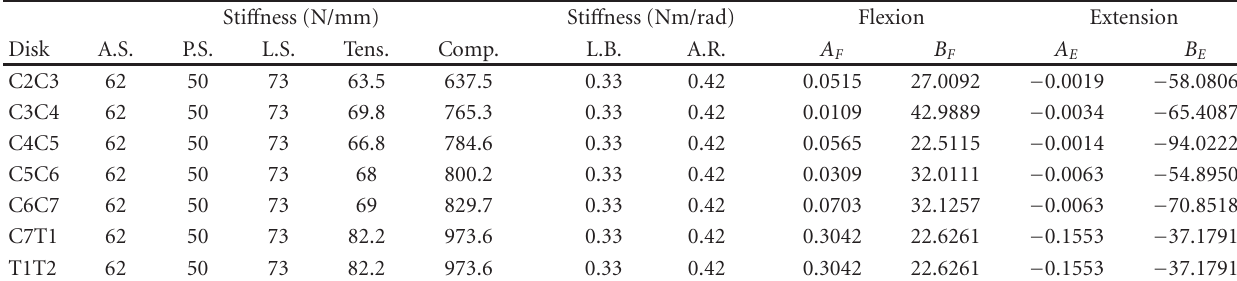
Table 2: Dynamic Characteristics of the Intervertebral Disks (Adapted from Van Lopik and Acar [6] and Camacho et al. [33]).